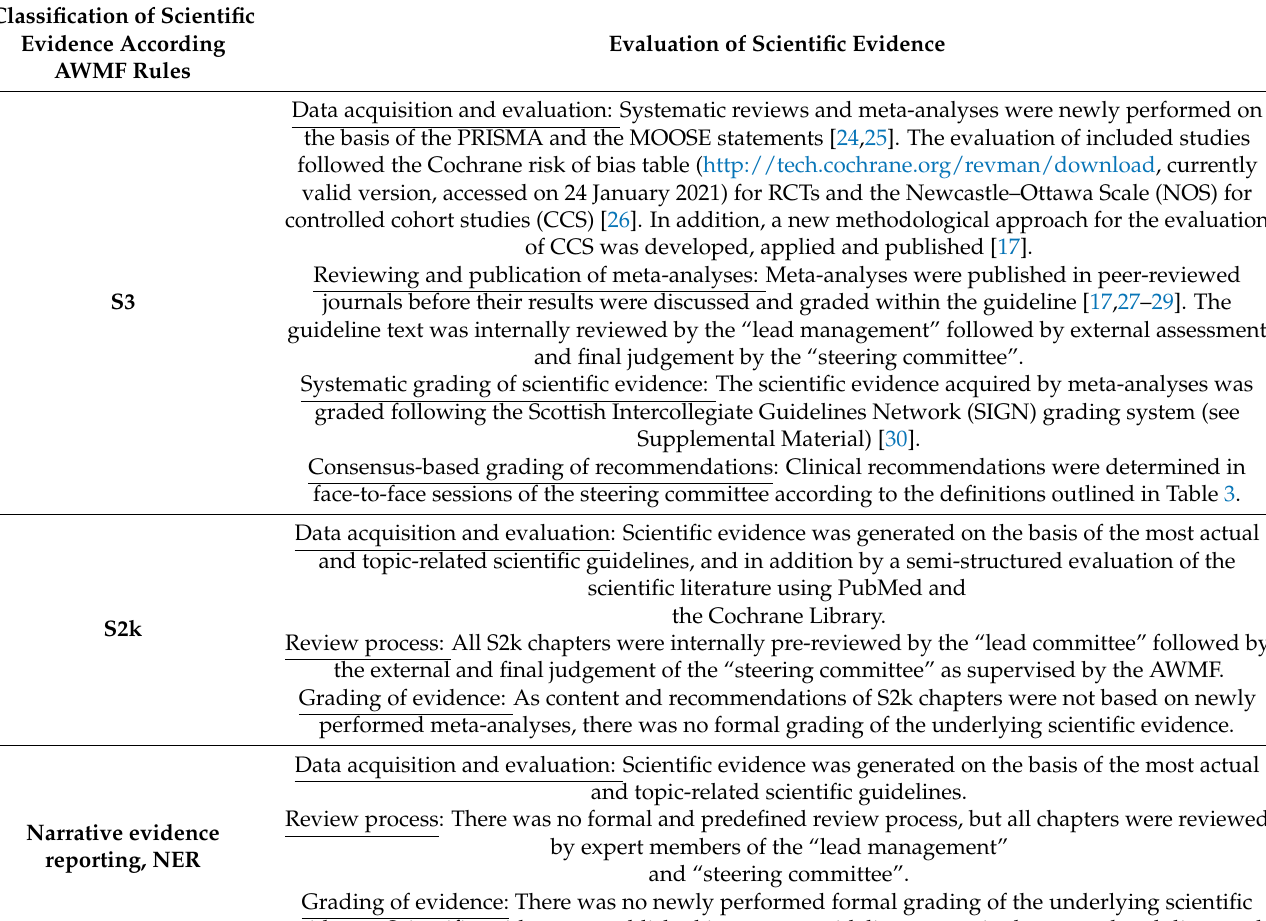
Table 2. LLKardReha-DACH: evidence generation—classification of evidence.